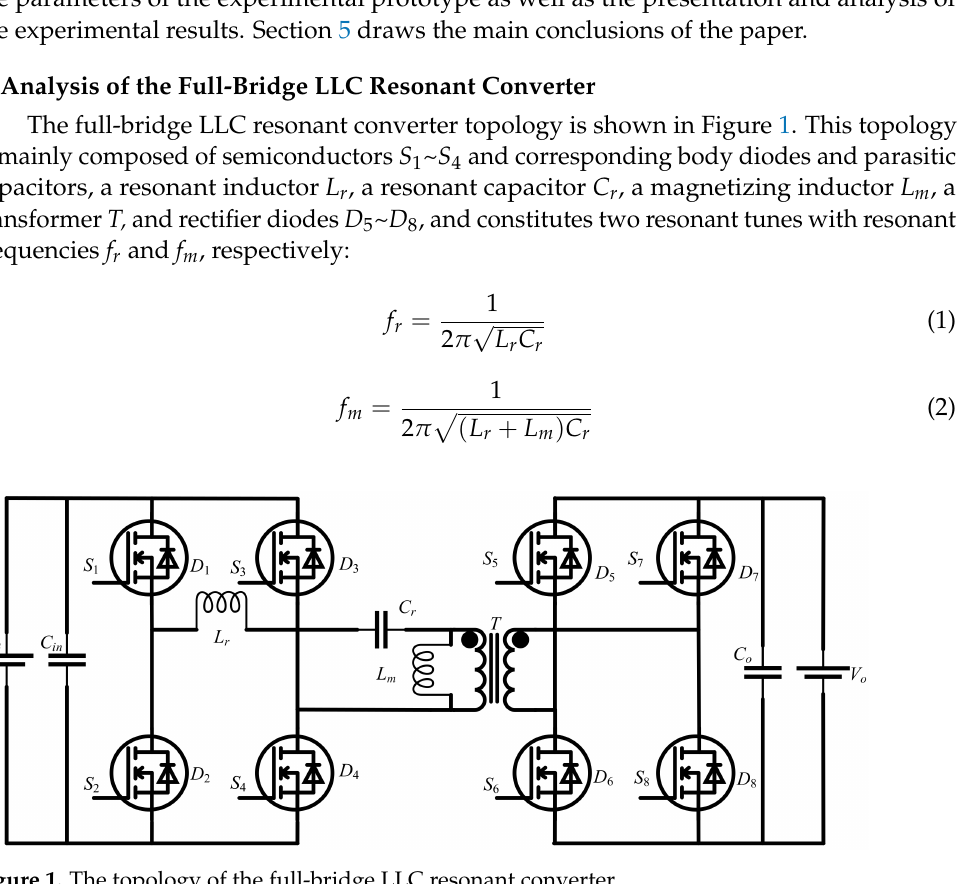
Figure 1. The topology of the full-bridge LLC resonant